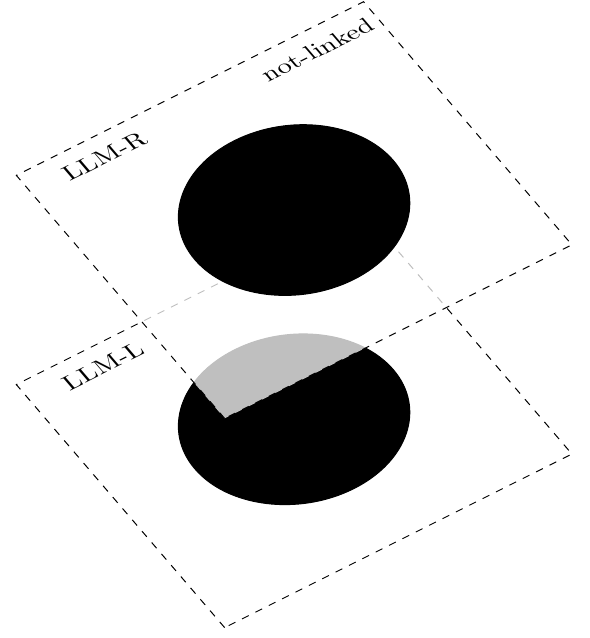
Figure 14 . Two unentangled LLM droplets corresponding to smooth one sided